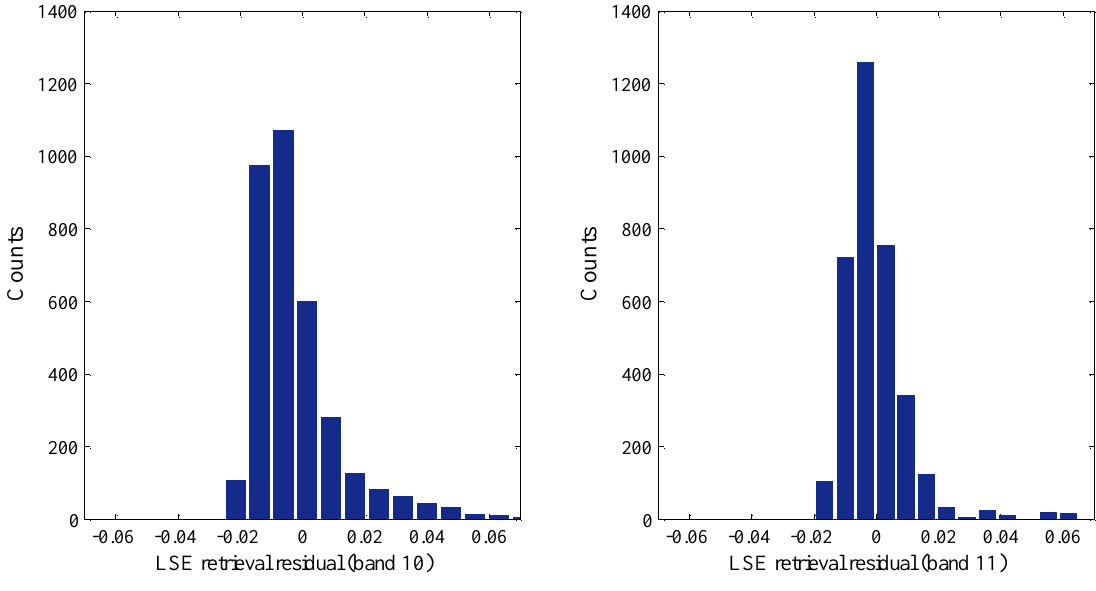
Figure 6. Histogram of the differences between the retrieved LSE and the reference